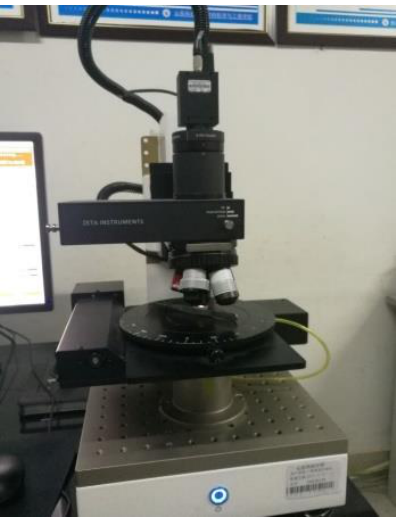
Figure 8. Three-dimensional topographic imager (Zeta-20).